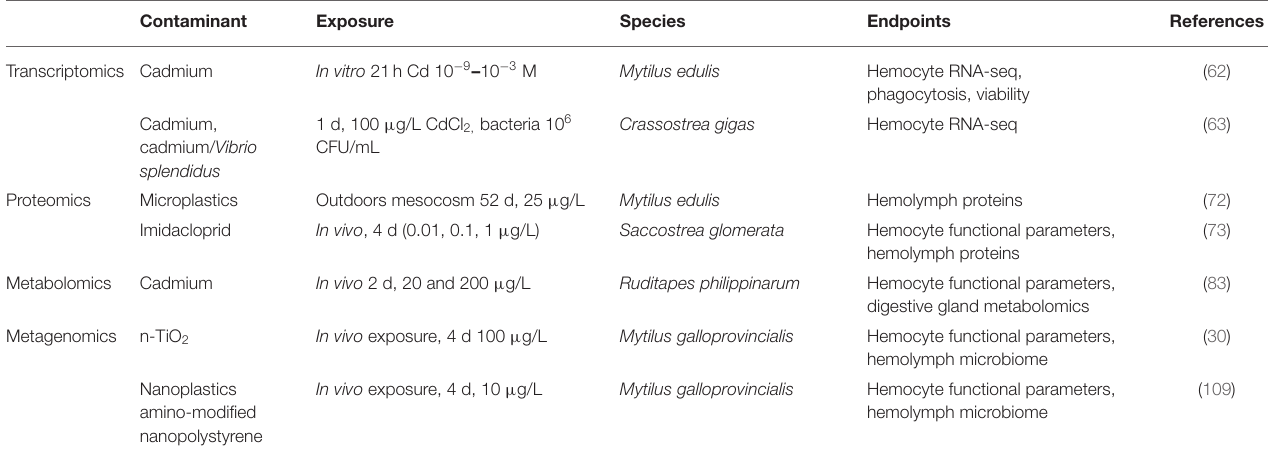
TABLE 1 | Summary of available publications focused on the application of -omics to evaluate the effects of pollutants on bivalve immune responses.